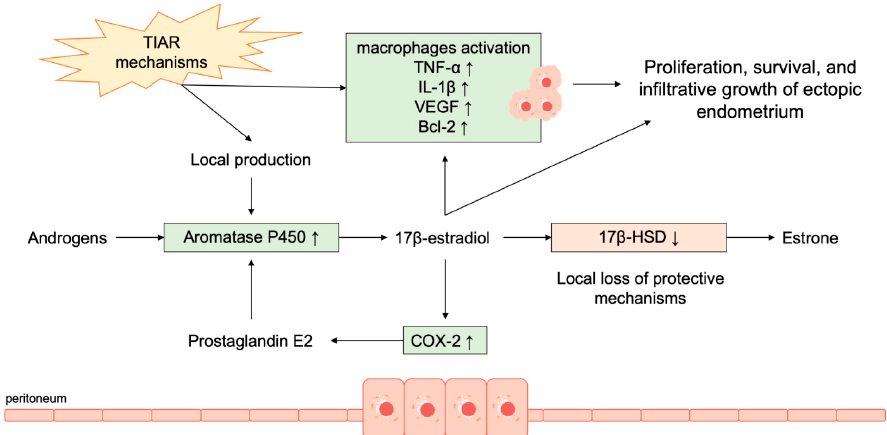
Figure 1. Summary of the mechanisms underlining the key role of estrogens in the pathogenesis of endometriosis. Tissue injury and repair (TIAR); Tumor necrosis factor (TNF); Interleukins (IL); Vascular endothelial growth factor (VEGF); Antiapoptotic protein B cell lymphoma 2 (Bcl-2); 17 β -hydroxysteroid dehydrogenase (17 β -HSD).